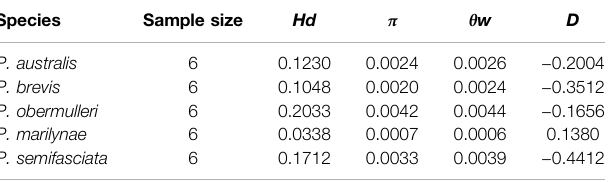
TABLE 2 | Estimated genome-wide genetic diversity of genus Pyrrhulina by species.